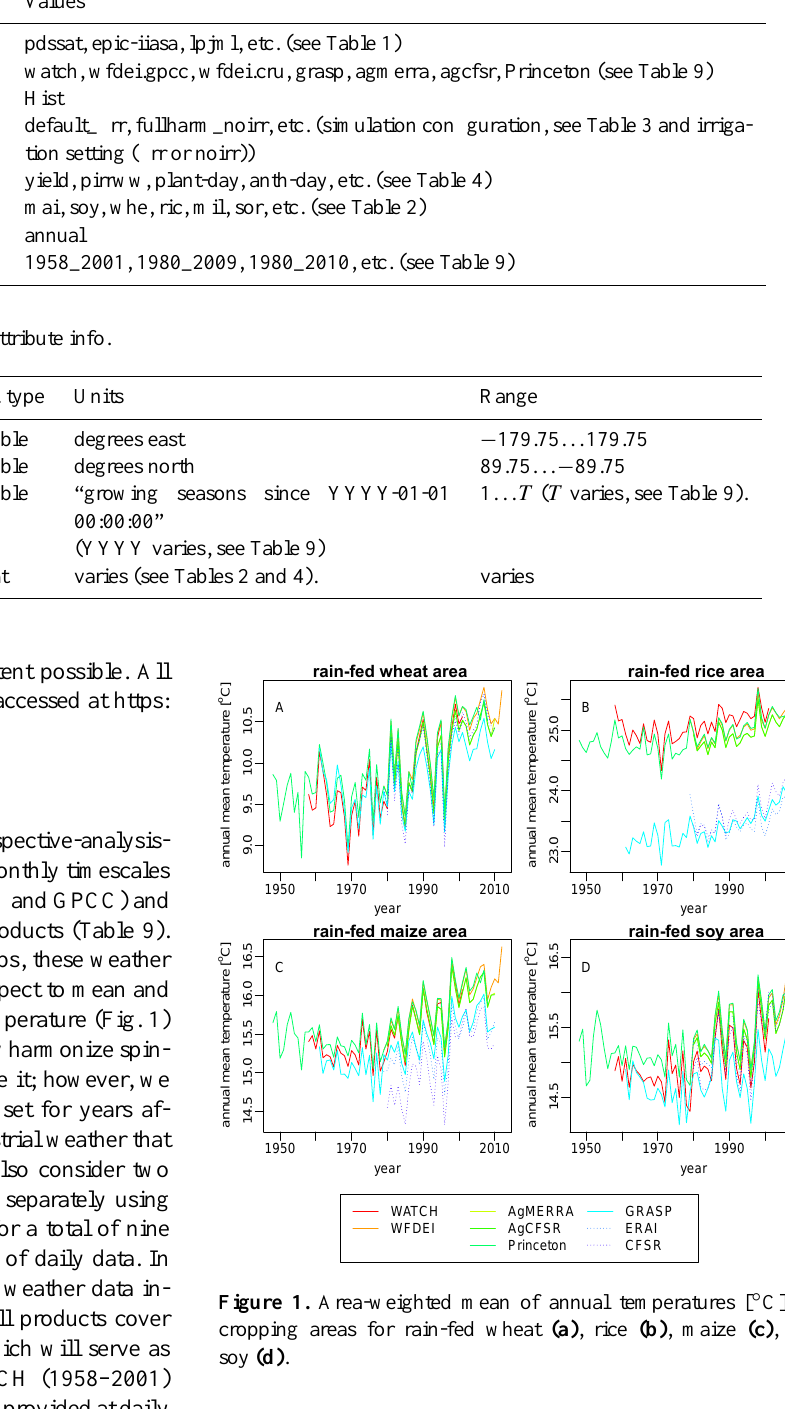
Different GGCMs can require different weather variables, which are supplied by the different forcing data sets.